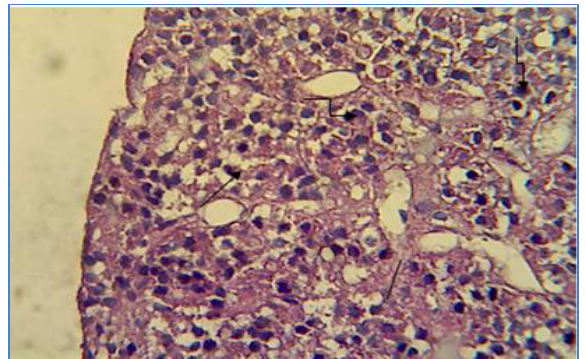
Figure, 4: Section in pituitary gland of control group shows normal structure of cellular composition of the pars distalis, chromophobes cells ( ) and chromophils cells ( ) (H and E stain 40 X).